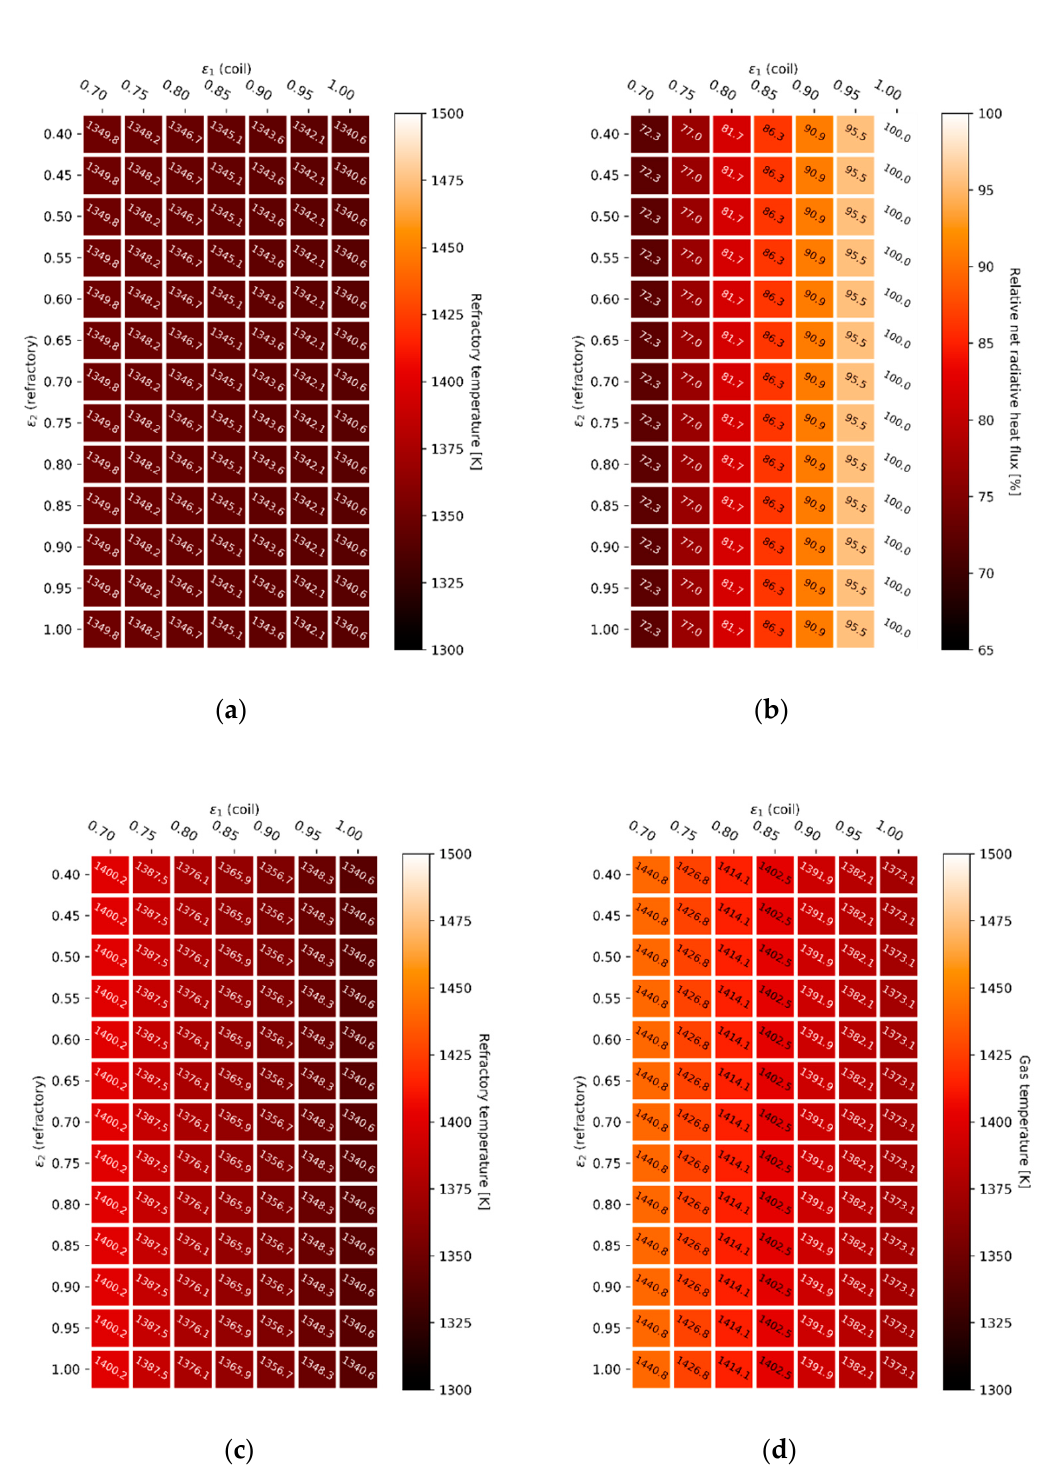
Figure 14. Refractory wall temperature ( a ) and radiative heat flux ( b ) for a constant gas phase temperature. Refractory wall temperature ( c ) and gas phase temperature ( d ) for a constant radiative heat flux in the presence of a gray gas.